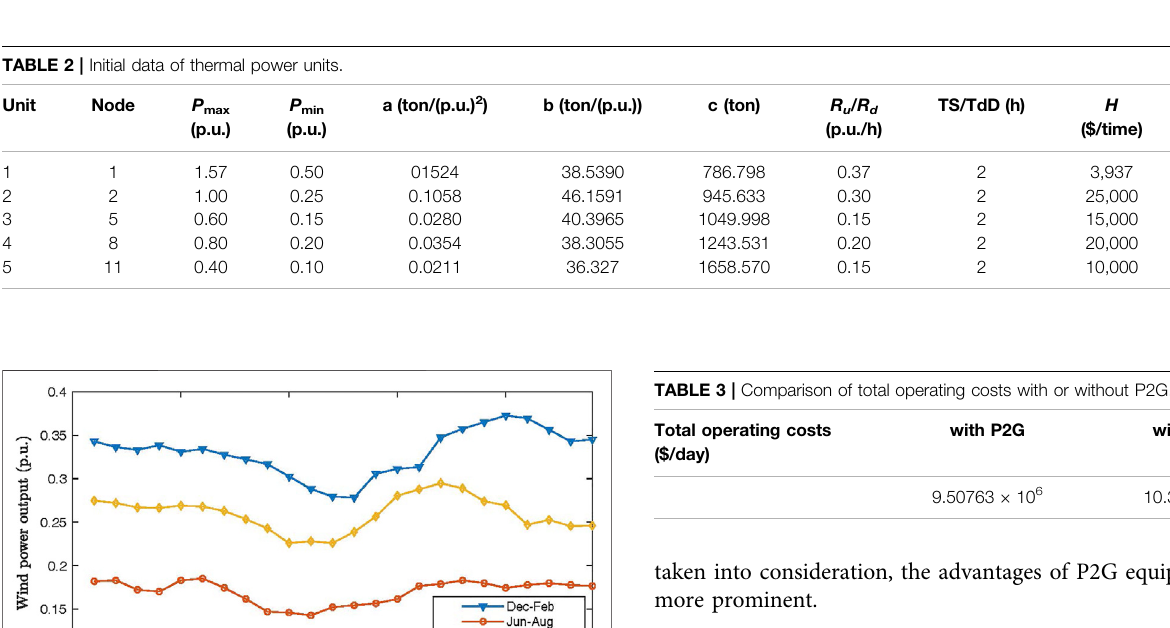
FIGURE 3 | IEGS case study diagram.